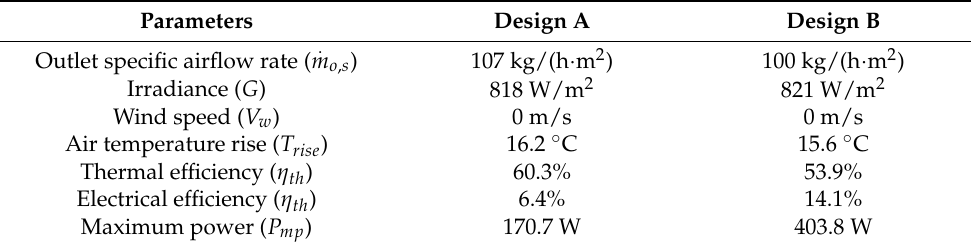
Table 11. Design A and B thermal performance characterization